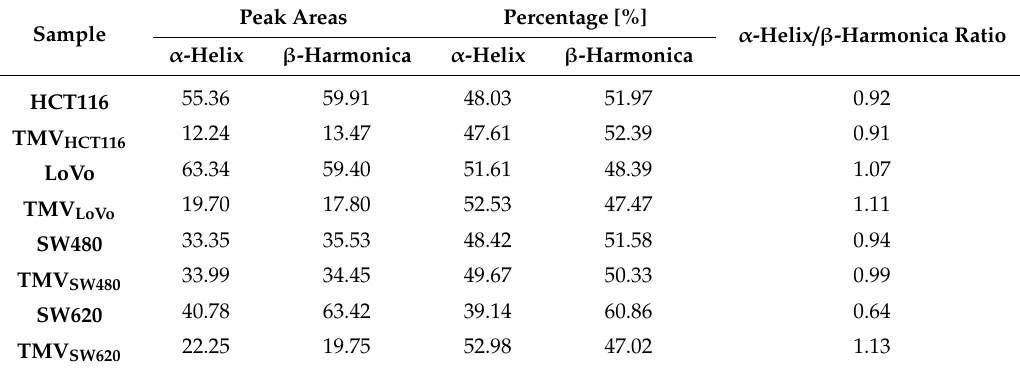
Table 2. Value of peak areas, percentage, and ratio of α and β secondary protein structures. Peak Sample